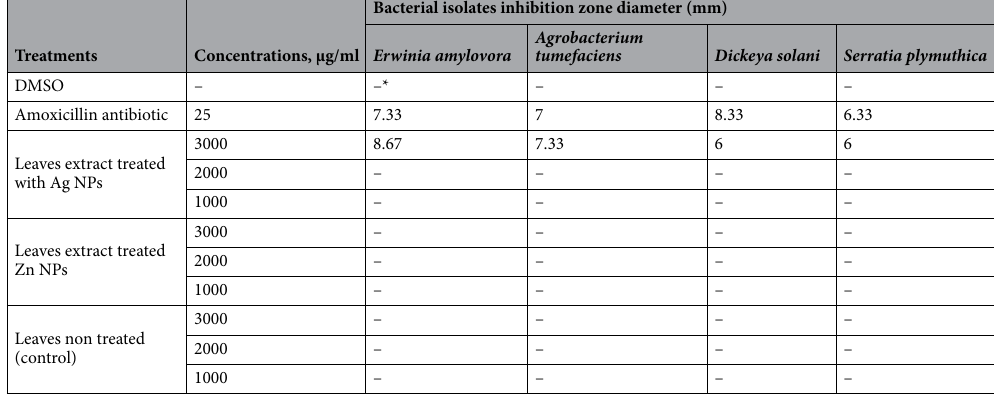
Table 6. Treatments and bacterial isolates inhibition zone diameter (mm) calculations. *–, mean there no effect.